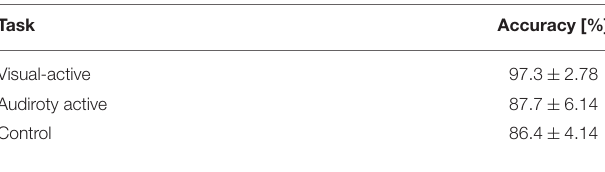
TABLE 2 | Accuracy of the answers.